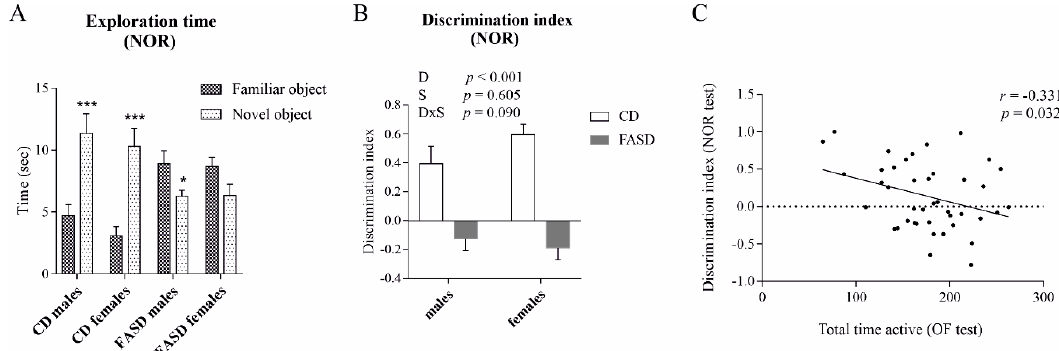
Figure 2. NOR test in 3-week-old male and female o ff spring. ( A ) CD pups spent more time exploring the novel object compared to the familiar object, whereas FASD pups spent the same or less time exploring the novel object compared to the familiar object. ( B ) Short-term memory impairment, indicated by the negative DI, was observed due to FASD during the NOR test. A negative DI (calculated as time spent exploring novel object minus time spent exploring familiar object divided by total time exploring both novel and familiar objects) indicates that less time was spent with the novel object compared to the familiar object. White bars: CD animals, gray bars: FASD animals. ( C ) DI negatively correlated with total activity time in the OF test. n = 10–13 / group, 9–11 litters / diet. Values are means ± SEM. p values from linear mixed-model analysis (including maternal diet and o ff spring sex as fixed factors and litter as a random factor) are indicated at the top of each graph. * p < 0.05, *** p < 0.001 ( t